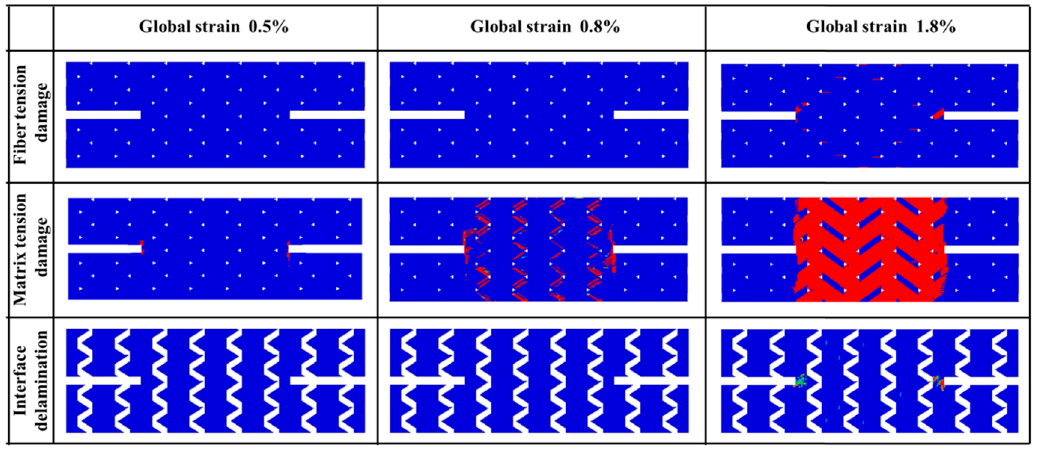
Figure 6. Comparison of numerical predicted damage development of axial tension.